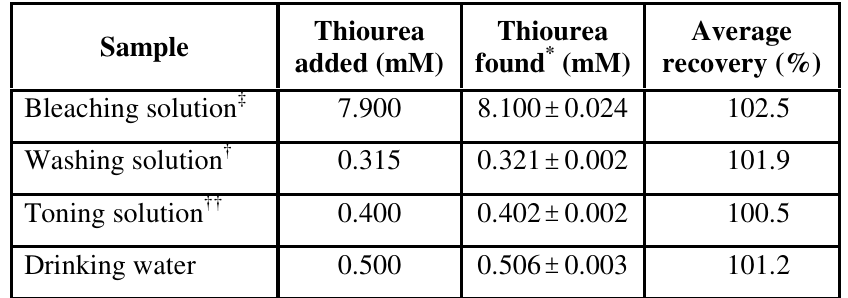
Table 2. Recovery of